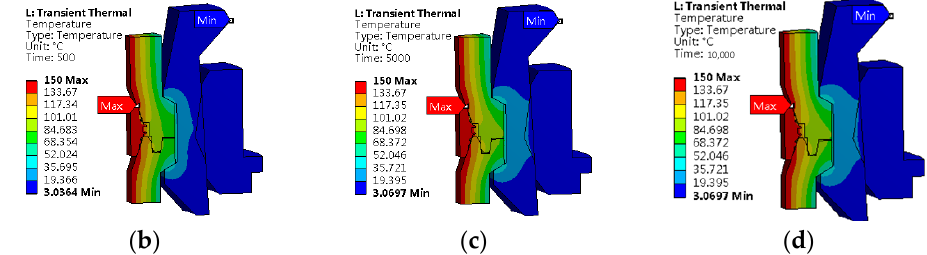
Figure 2. Transient temperature field of subsea collet connector under the working condition of uniform temperature rise. ( a ) 50 s; ( b ) 500 s; ( c ) 5000 s; ( d ) 10,000 s.